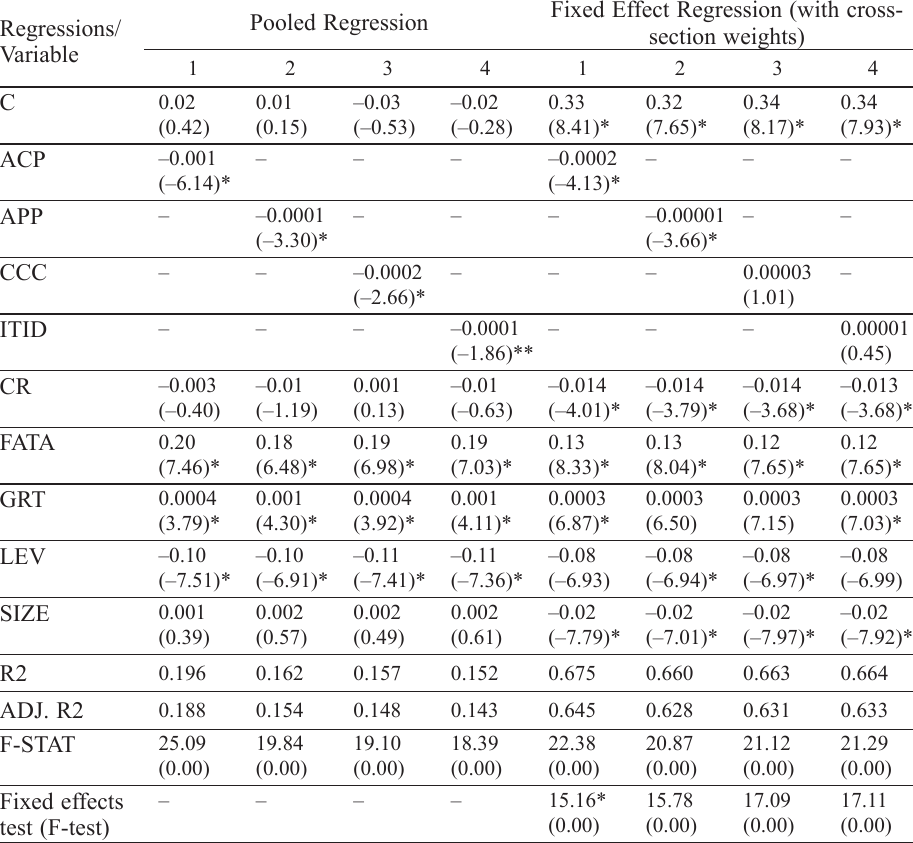
Table 3c. Regression of return on assets on working capital variables